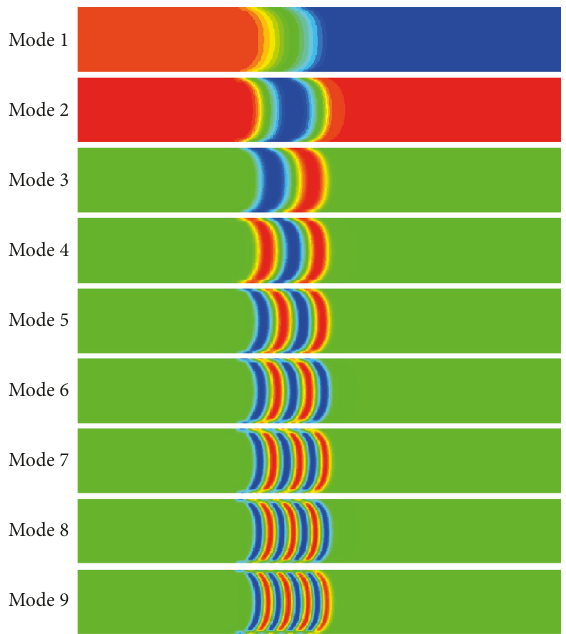
Figure 9: Flame propagation of the subsequent stage for the di- mensionless at the first 9 different